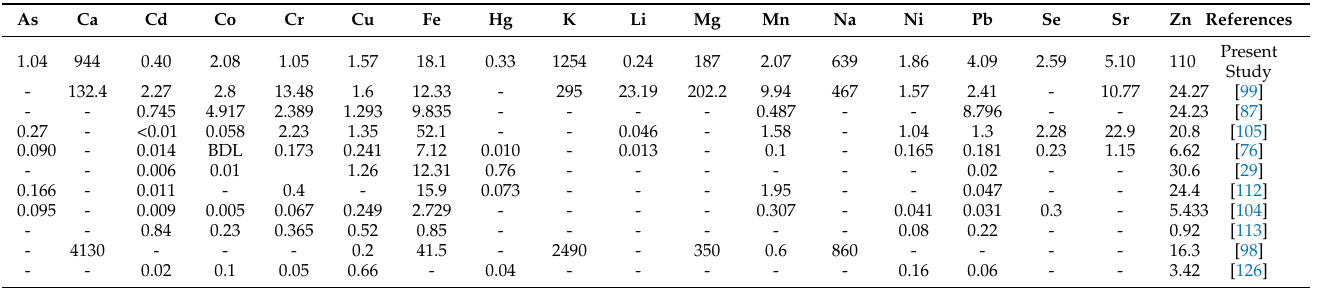
Table 3. Comparison of measured average metal levels ( µ g/g) in the muscles of Catla catla and other reported levels